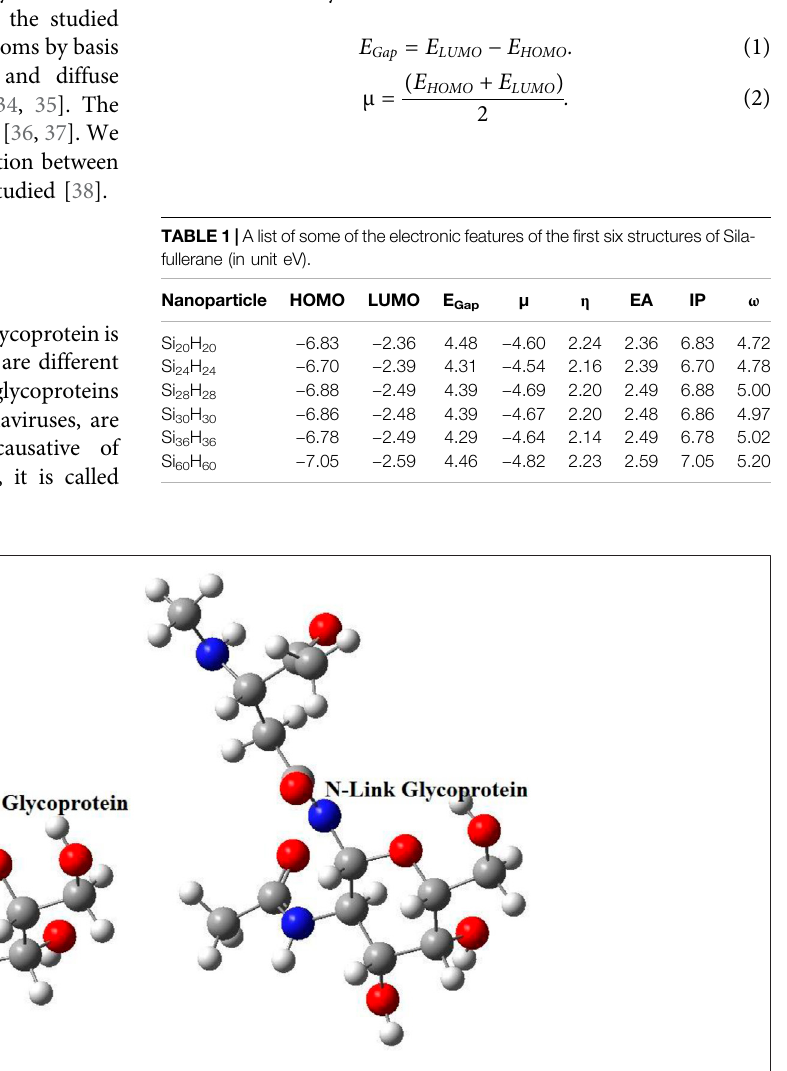
FIGURE 1 | The common glycoproteins, which make up virus spikes, are N-Link and O-Link types.